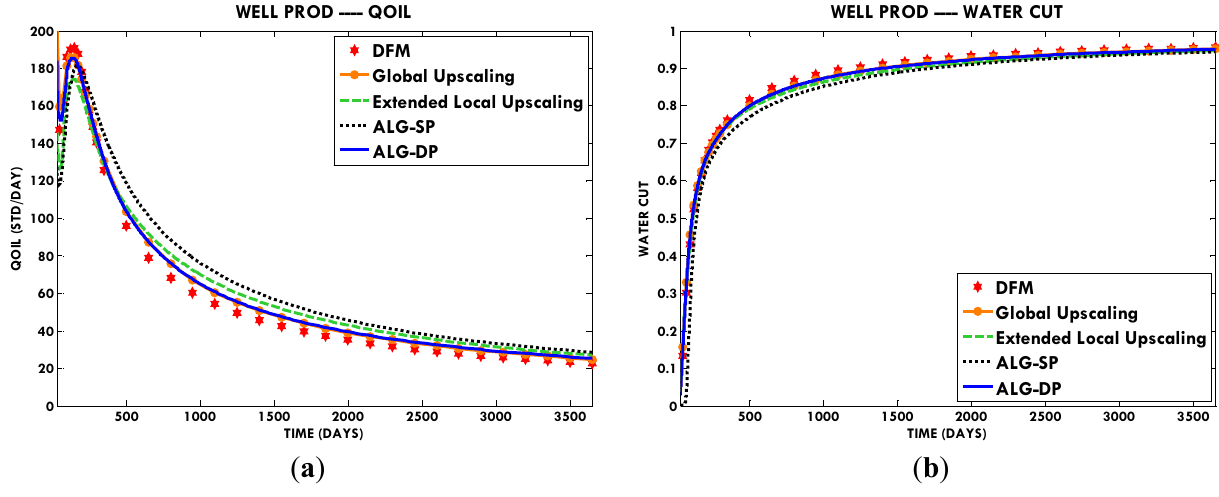
Figure 4. ( a ) Oil rate and ( b ) water cut of production well for case 1.